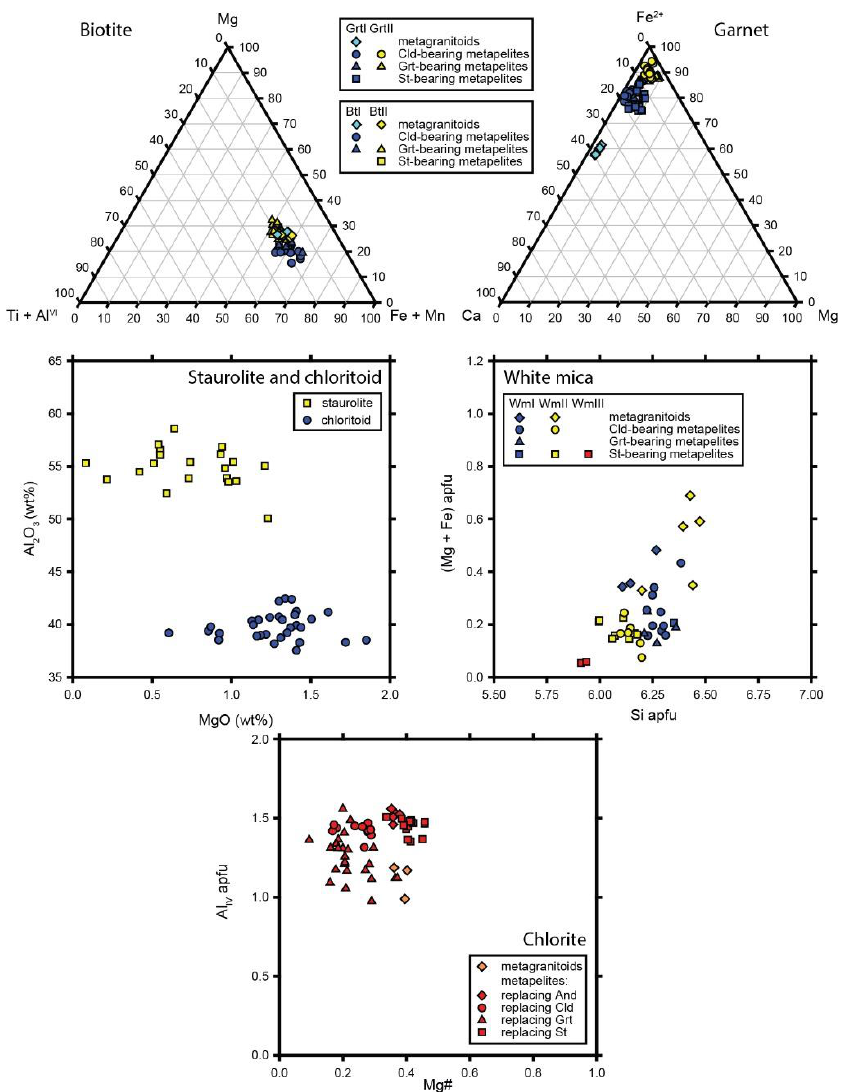
Figure 8. Compositional variations of the main rock-forming minerals in metapelites and metagranitoids as a function of rock-type (triangle: garnet-bearing metapelites, circle: chloritoid-bearing metapelites, square: staurolite-bearing metapelites) and microstructural site (D1a—blue, D1b—yellow, D2—red).